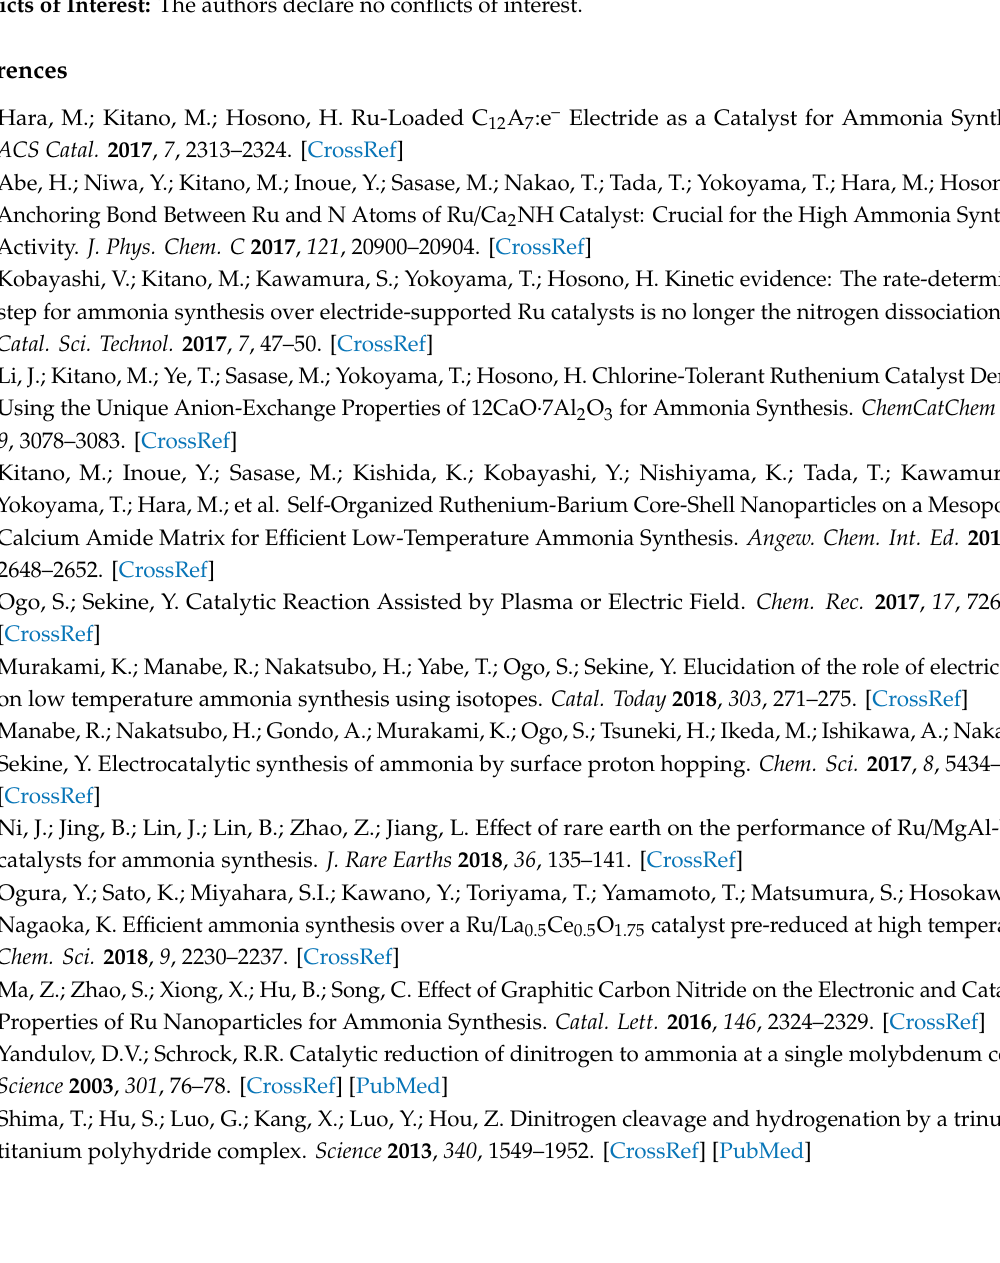
Figure S1: Overall view and sectional view of the reactor, Figure S2: Waveforms of voltage and current, Figure S3: The Lissajous curves of V(t) and I(t) for the plasma reactions, Table S1: detailed data of Figure 1. Author Contributions: Conceptualization, M.I.; reaction on Ni / Al 2 O 3 , M.H., T.S. and K.S.; reaction on metal oxides, R.H.; reaction on Ni / TiO 2 , H.T.; writing—original draft preparation, review and editing, M.I.;